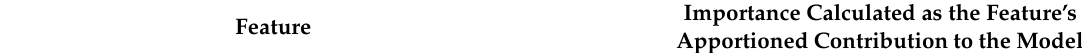
Table A4. The features used in our final model and their importance